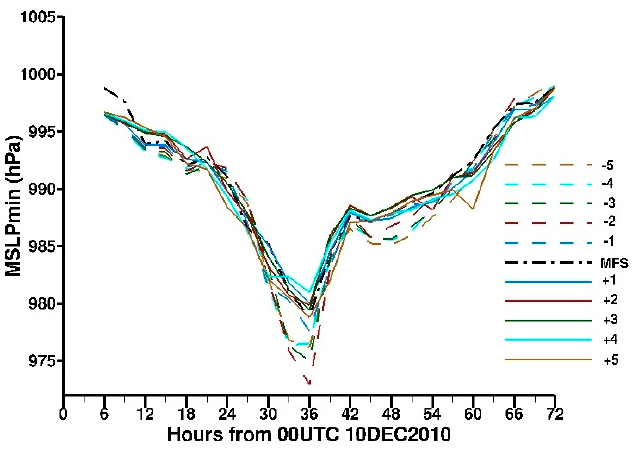
Figure 28. Time series of the minimum MSLP for the secondary low for the MFS run (black) and the 10 SST anomaly experiments (solid lines for warmer SSTs and dashed lines for cooler SSTs).